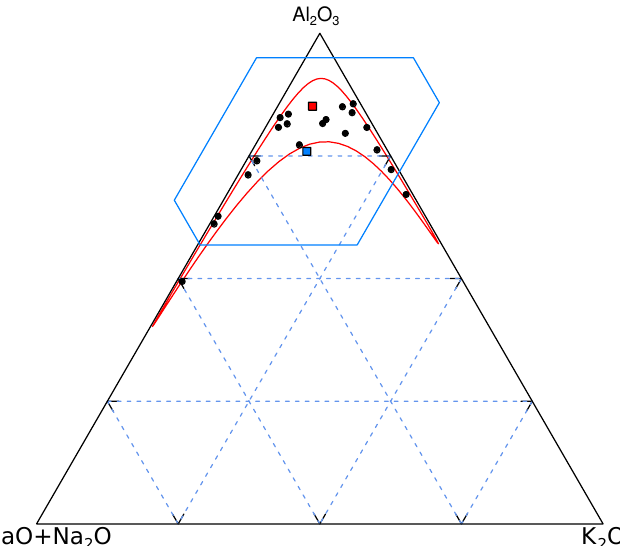
Figure 1. Graphical output of Section 3. Black circles mark 20 synthetic Al 2 O 3 , (CaO + Na 2 O) and K 2 O compositions, drawn from a logistic normal distribution. The blue square marks the arithmetic mean, which falls outside the data cloud. The blue polygon marks a 2- σ confidence polygon, which plots outside the ternary diagram, in physically impossible negative space. The red square represents the logratio mean, which firmly plots inside the data cloud. The red confidence envelope marks a 95% confidence region calculated using Aitchison’s logratio approach. This confidence envelope neatly fits inside the ternary diagram and tightly hugs the